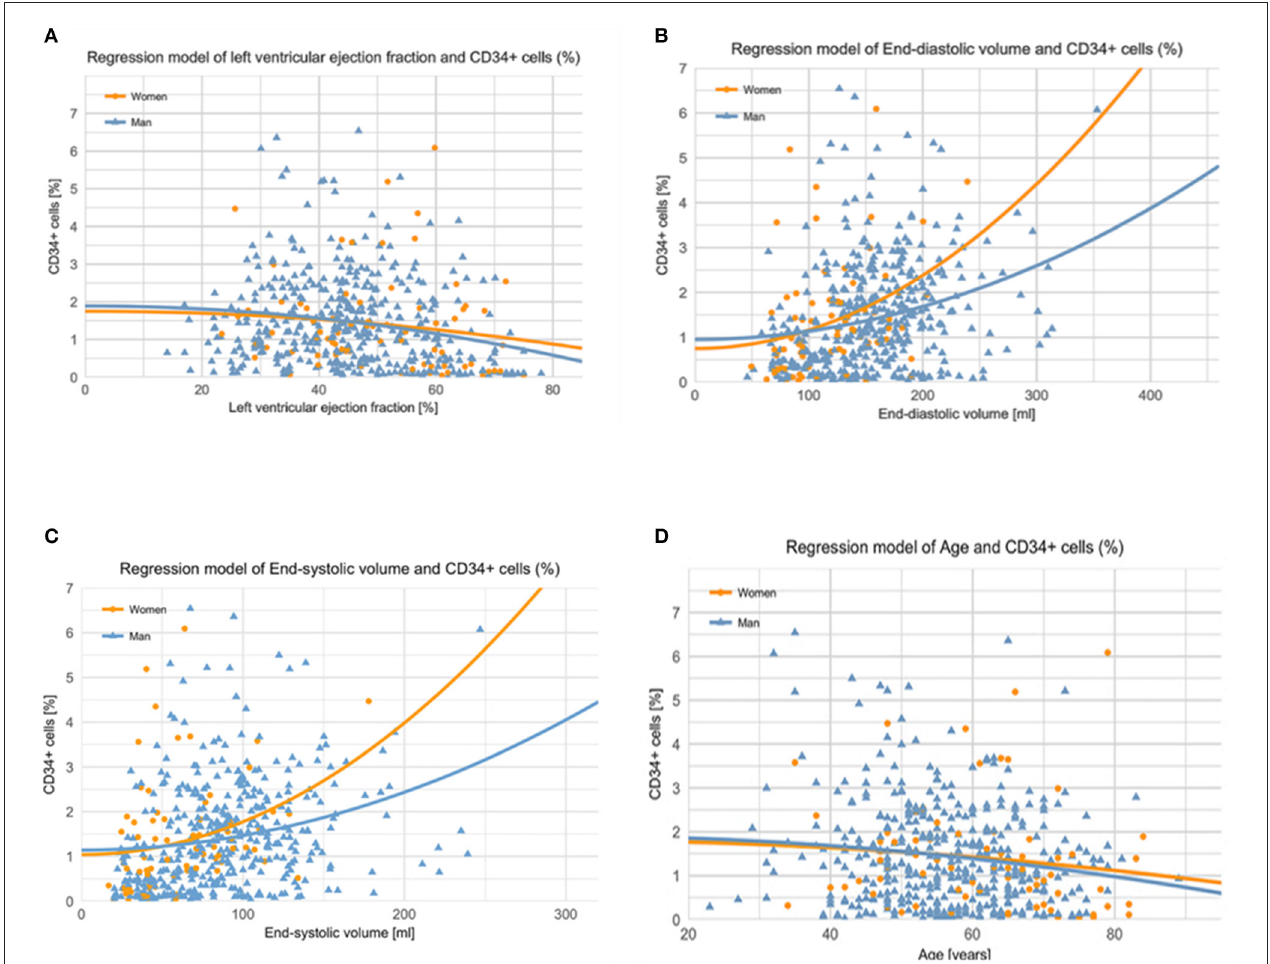
FIGURE 3 | (A) Correlation of baseline left ventricular ejection fraction with CD34 + cells. Left ventricular ejection fraction (EF) values correlated negatively with the percentage of CD34 + cells. The higher the EF is, the lower the number of BM-origin CD34 + cells (in percentage) in both sexes. The results were similar in men and women. Men: r = 0.282; y (lnCD34posPercent) = 2.81–0.025xEF (men); p < 0.001. Women: r = 0.32; y (lnCD34posPercent) = 3.547–0.029xEF (women); p = 0.001. (B) End-diastolic volume (EDV) values showed a significant exponential correlation with the percentage of CD34 + cells, suggesting an intrinsic repair mechanism in both sexes. The left shift of the curve in women indicates that a smaller EDV value was associated with a higher percentage of CD34 + cells in women. Men: r = 0.26; y (lnCD34posPercent) = 0.351 + 0.006xEDV (men); p < 0.001. Women: r = 0.362; y (lnCD34posPercent) = 0.243 + 0.011xEDV (women); p = 0.002. (C) Correlation of baseline end-systolic volume with CD34 + cells. End-systolic volume (ESV) showed an exponential correlation with the number of BM-origin CD34 + cells (in percentage). The left shift of the curve in women indicates that a smaller ESV results in a higher percentage of CD34 + cells in women as compared to men. Men: r = 0.316; y (lnCD34posercent) = 0.406 + 0.009xESV (men); p < 0.001. Women: r = 0.407; y (lnCD34posPercent) = 0.334 + 0.015xESV (women); p < 0.001. (D) Correlation of patient age with CD34 + cells. Age was negatively, weakly correlated with CD34 + cells in women, with a non-significant correlation in men. The lower the age of women, the higher the number of BM-origin CD34 + cells [in percentage]. Men: r = 0.094; y (lnCD34posPercent) = 1.60–0.01xAge (men); p = 0.054. Women: r = 0.285; y (lnCD34posPercent) = 4.52–0.027xAge (women); p =